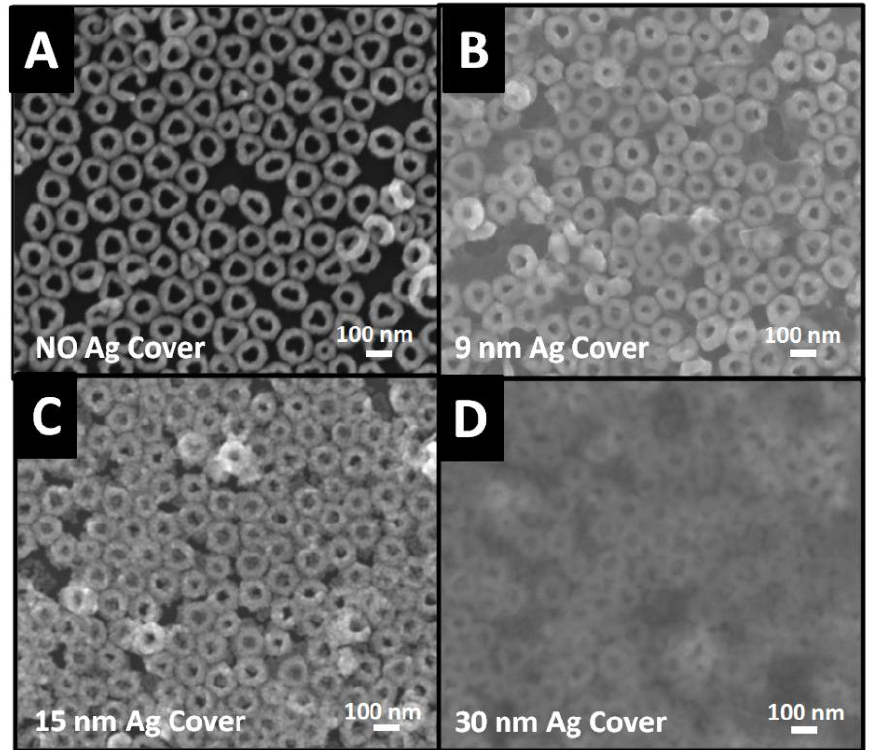
Figure 3. SEM images of Ag covers deposited on monolayered Au nanorings with different thickness: ( A ) 0 nm, ( B ) 9 nm, ( C ) 15 nm, and ( D ) 30 nm. The surface morphology of Ag cover may be affected during SEM measurements.